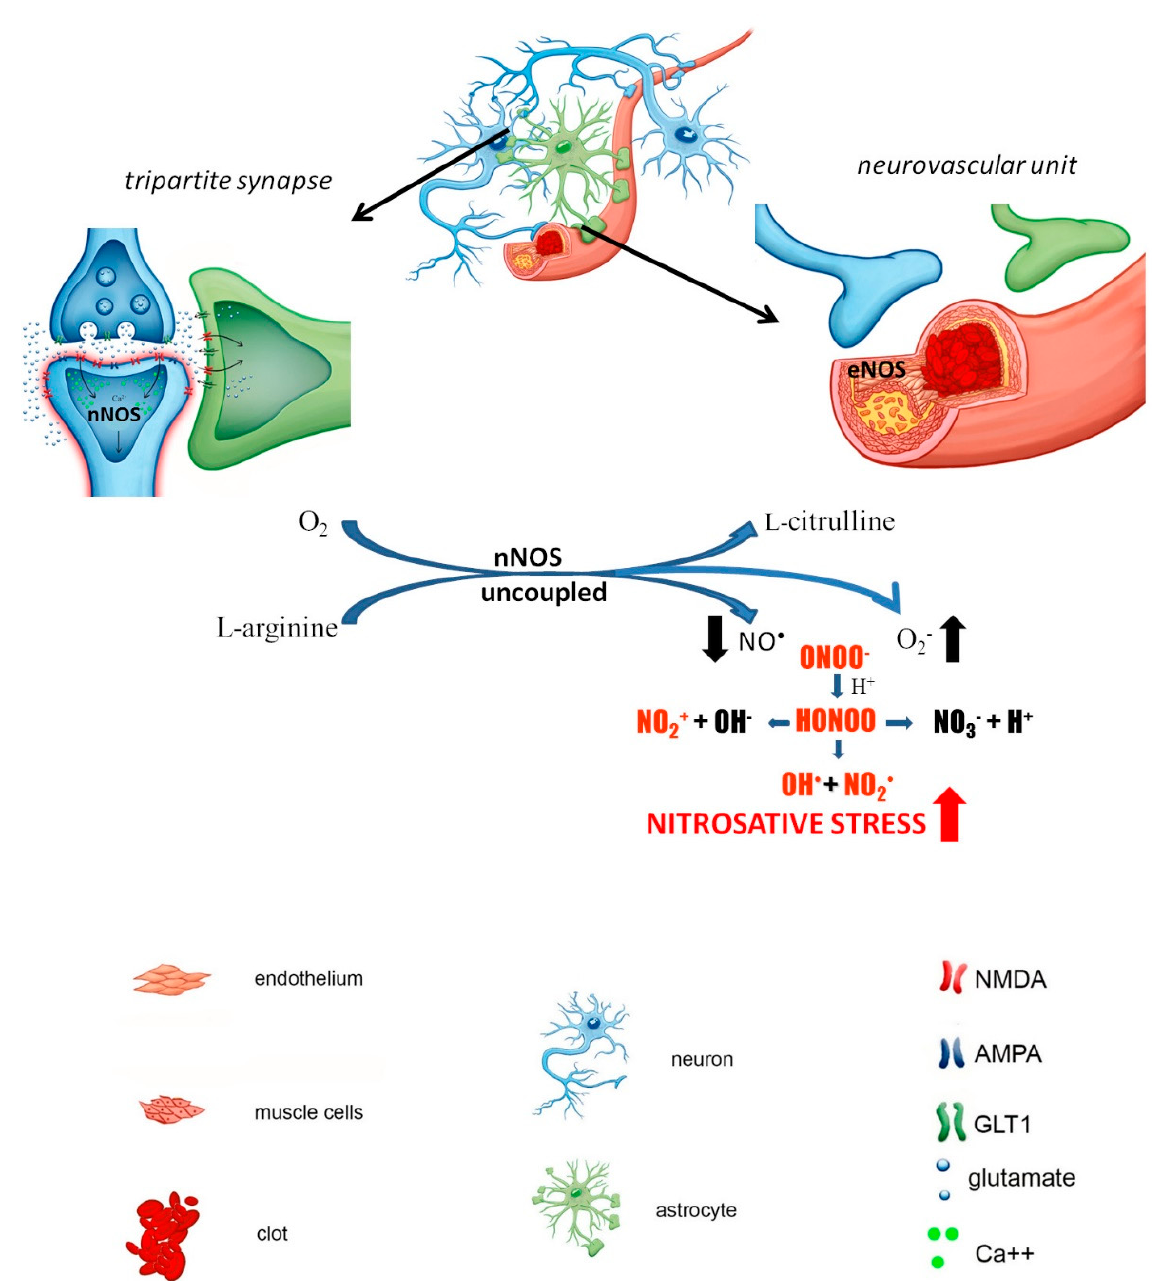
Figure 2. Early stage of the ischemia (early neuronal damage (0–6 h after ischemic episode): when the clot is formed due to atherosclerotic plaque, under restriction of oxygen supply, the glutamate released by presynaptic neuron accumulates in the synaptic cleft due to reversed activity of GLT1 transporter in the astrocyte; this leads to overactivation of postsynaptic neuron, overactivation of voltage-dependent calcium channels and Ca 2+ influx into postsynaptic neuron, that leads to overactivation of nNOS and its uncoupling, and accumulation of ROS/RNS, instead of cGMP.